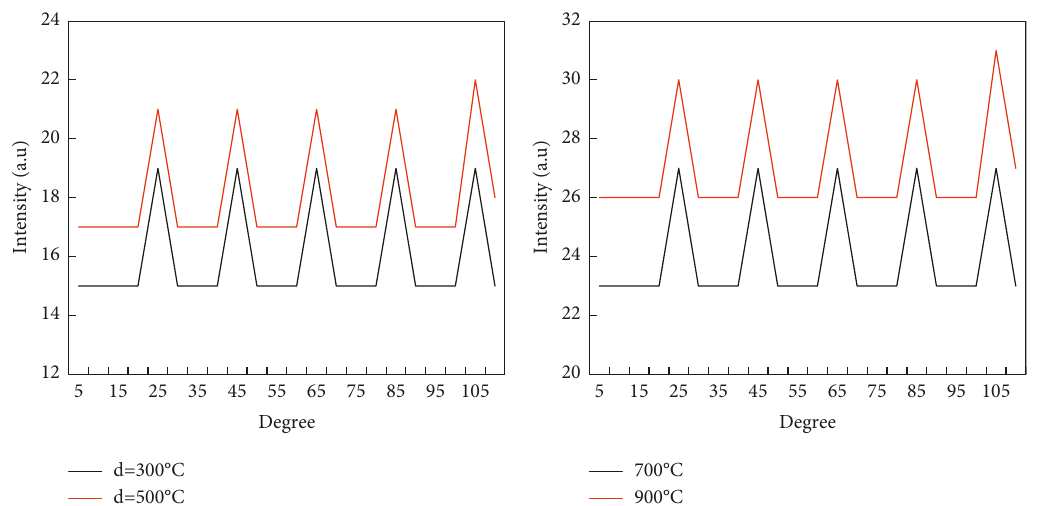
Figure 7: The anatase phase diffraction peaks after acid treatment change with temperature.